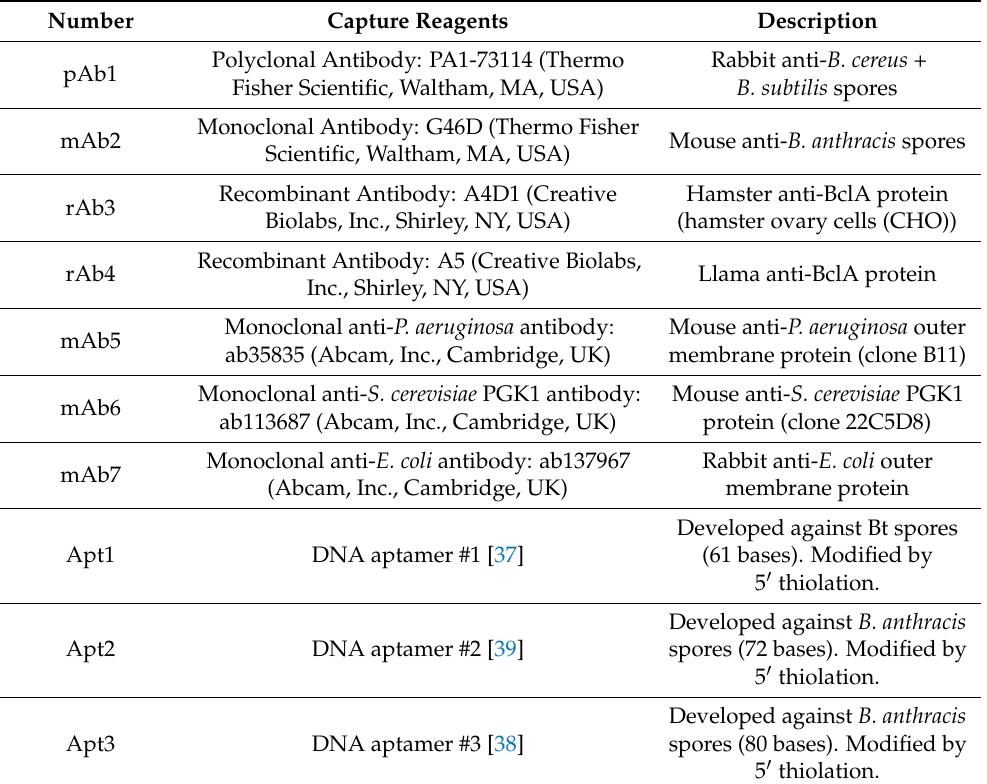
Table 1. Capture reagents used in this